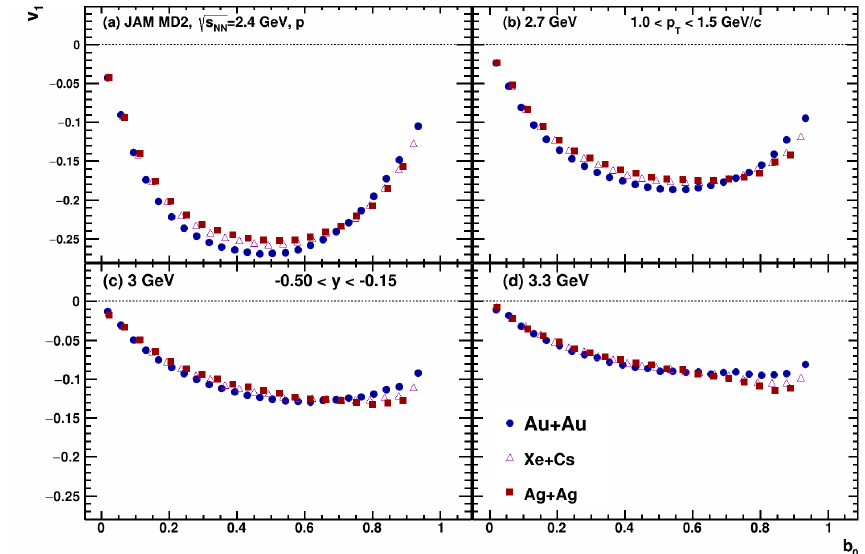
Figure 23. Scaled impact parameter b 0 dependence of directed flow v 1 of protons in the transverse momentum interval 1.0 < p T < 1.5 GeV/c and rapidity interval − 0.5 < | y cm | < − 0.15 from Au + Au (closed circles), Xe + Cs (open triangles), Ag + Ag (closed boxes) collisions at energies (panel ( a )), 2.7 GeV (panel ( b )), 3 GeV (panel ( c )) and 3.3 GeV (panel ( d )). The results for JAM model with hard momentum dependent mean-field MD2 ( K 0 = 380 MeV)